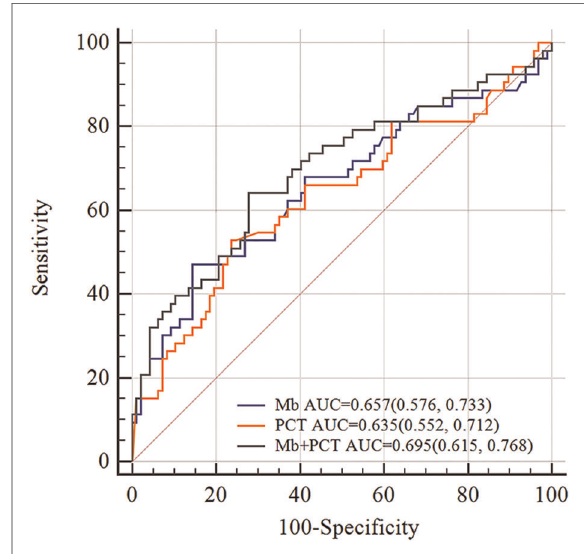
FIGURE 2 ROC curves of Mb, PCT, and Mb + PCT for EAD. The AUC values of Mb, PCT, and Mb+PCT were 0.657, 0.635, and 0.695, respectively. In total, 1327 ng/ml was the best cutoff value of myoglobin for predicting EAD (sensitivity=47.2%, speci fi city=85.6%). AUC, area under the curve.